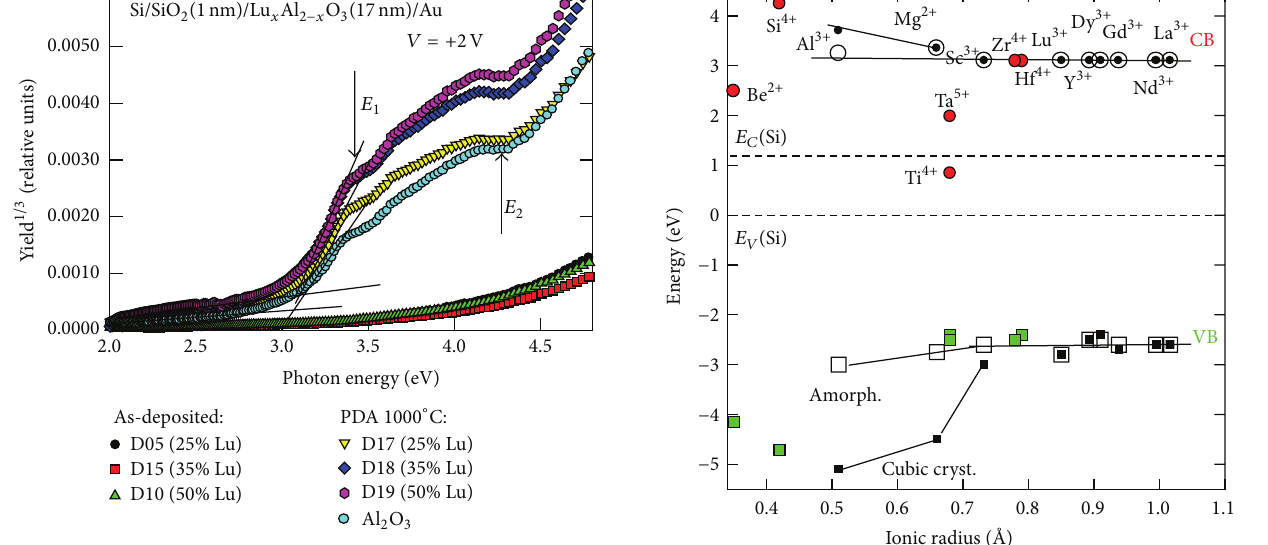
Figure 14: Cube root of the IPE yield as a function of photon energy as inferred from the data shown in Figure 13. The inferred spectral threshold Φ 𝑒 of electron IPE from the VB of Si into the CB of Lu 𝑥 Al 1−𝑥 O 3 is indicated by vertical line. The arrows 𝐸 1 and 𝐸 2 indicate onsets of direct optical transition in the silicon crystal.